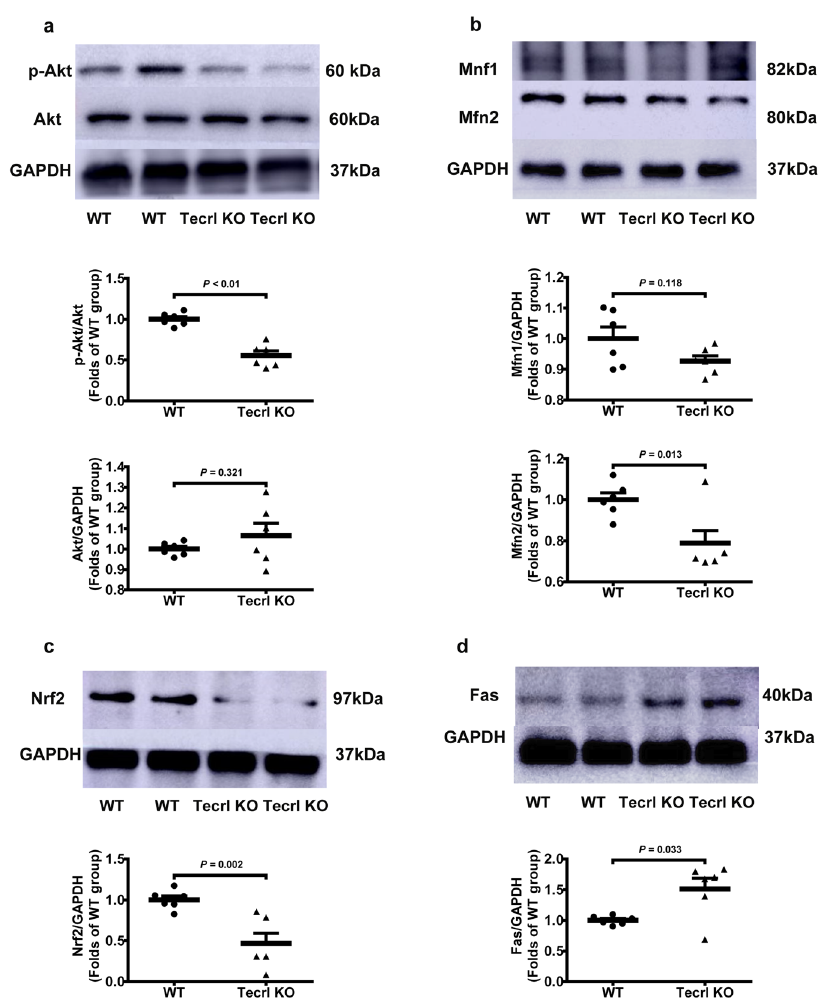
Fig. 5 Tecrl regulates mitochondrial function through PI3K/Akt signaling and mitochondrial fusion protein MFN2. a – d Representative immunoblotting images and quanti fi cation of the expression of p-Akt, Mfn1, Mfn2, Nrf2, Fas, and Tecrl in WT and Tecrl KO mouse hearts ( n = 6). Values are mean ± SE. P < 0.05 was considered signi fi